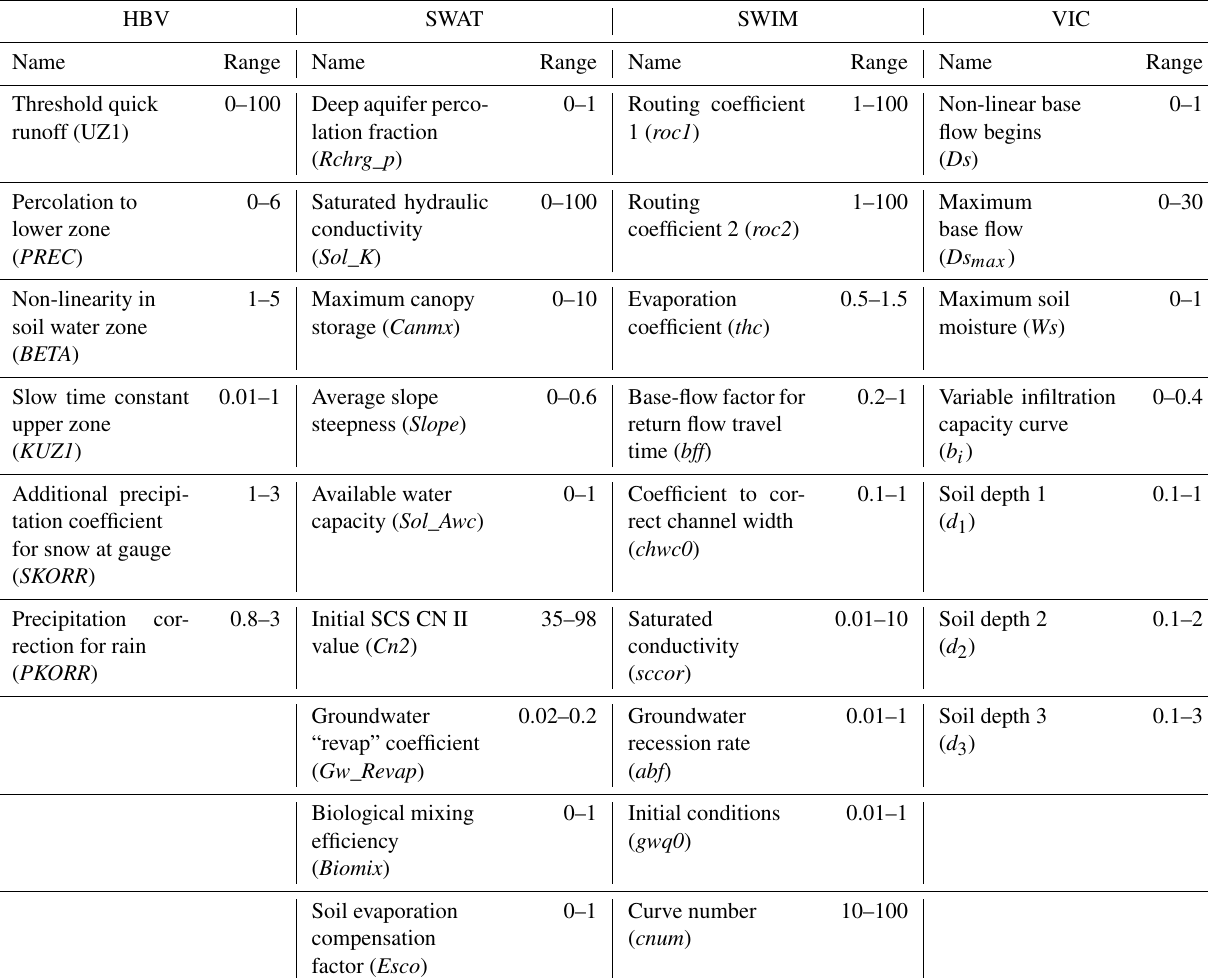
Table 3. The parameters and their ranges used for calibration of four hydrological models.